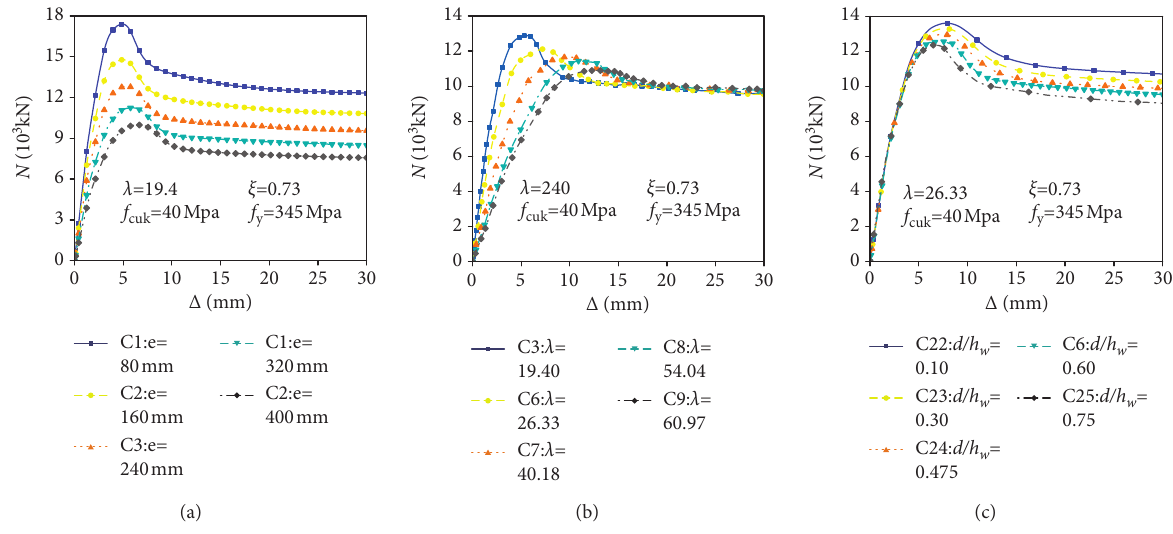
Figure 6: Comparisons of N- Δ curves of STHCCs with different parameters. (a) e . (b) λ . (c) d / h